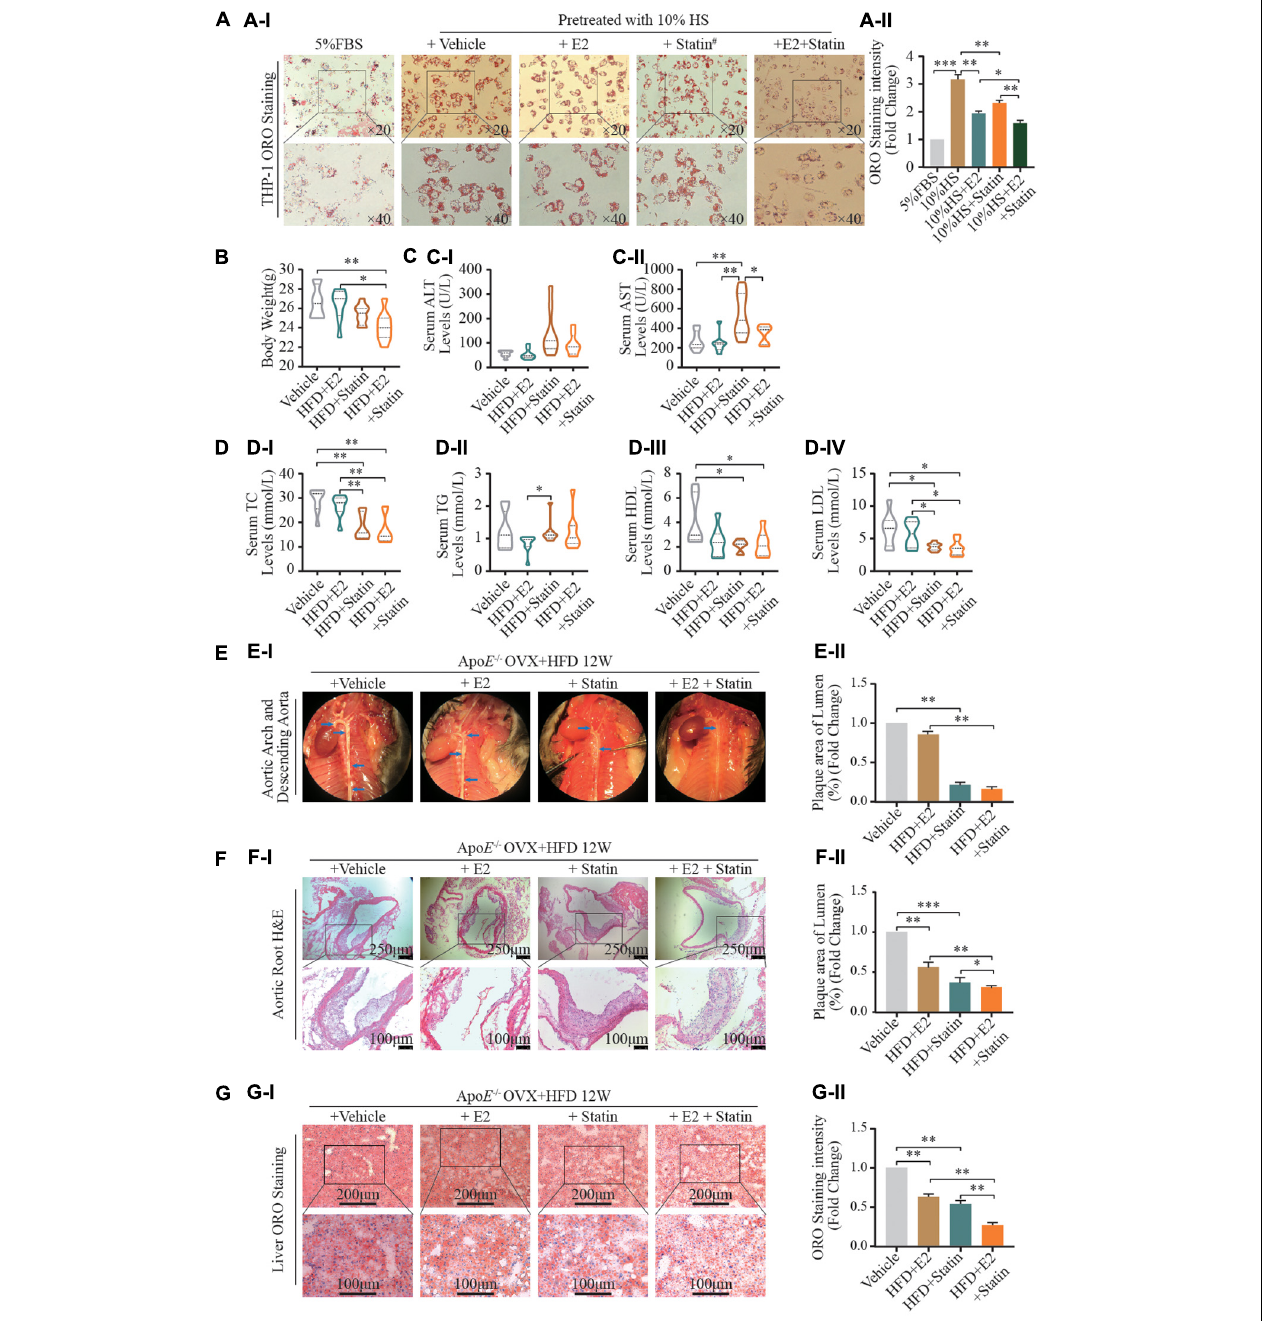
FIGURE 4 | E2/ESR α regulates SREBP-1 expression. (A–C) HepG-2 cells were cultured for 7 days in phenol red-free medium supplemented with 5% FBS, cells were transfected with pcDNA control, ESR α , ESR α and ESR α shRNA, after gene transfection, the cells were subsequently cultured with 10 nM E2 for 48 h and harvested for RT-qPCR (A) , western blotting (B), and immunofluorescence (C) to detect the mRNA and protein expression alteration of ESR α , pre-SREBP-1 and n-SREBP-1. immunofluorescence was visualized under confocal microscopy; DAPI stains the nucleus (blue), ESR α (green) ( n = 5 ∼ 8 cells/field/slice, n = 3 slices/group). (D) Representative ORO staining (DI) and quantification (DII) of red dot intensity in HepG2 cells after interference with pcDNA control, ESR α , ESR α & ESR α shRNA, and ESR α & SREBP-1 shRNA plasmid. (E) Representative images (EI) and quantification (EII) of intracellular LDL in HepG2 cells after interference with pcDNA control, ESR α , ESR α and ESR α shRNA, and ESR α and SREBP-1 shRNA plasmid. Red: DyLight 550-marked LDL. (F,G) After gene transfection, HepG2 and THP-1 cells were subsequently cultured with or without p-mTOR inhibitor AZD8055 (20 nM) for 48 h, cells were harvested for western blotting, representative blotting images (FI,GI) and quantification (FII,GII) of mTOR, p-mTOR, pre-SREBP-1 and n-SREBP-1, and ESR α . Data illustrated on the bar graph are the mean ± SD. All representative images presented were repeated in three independent experiments. Student’s t -test was used to evaluate the significance in differences between two groups of observations, ∗ P < 0.05; ∗∗ P < 0.01; ∗∗∗ P < 0.001.